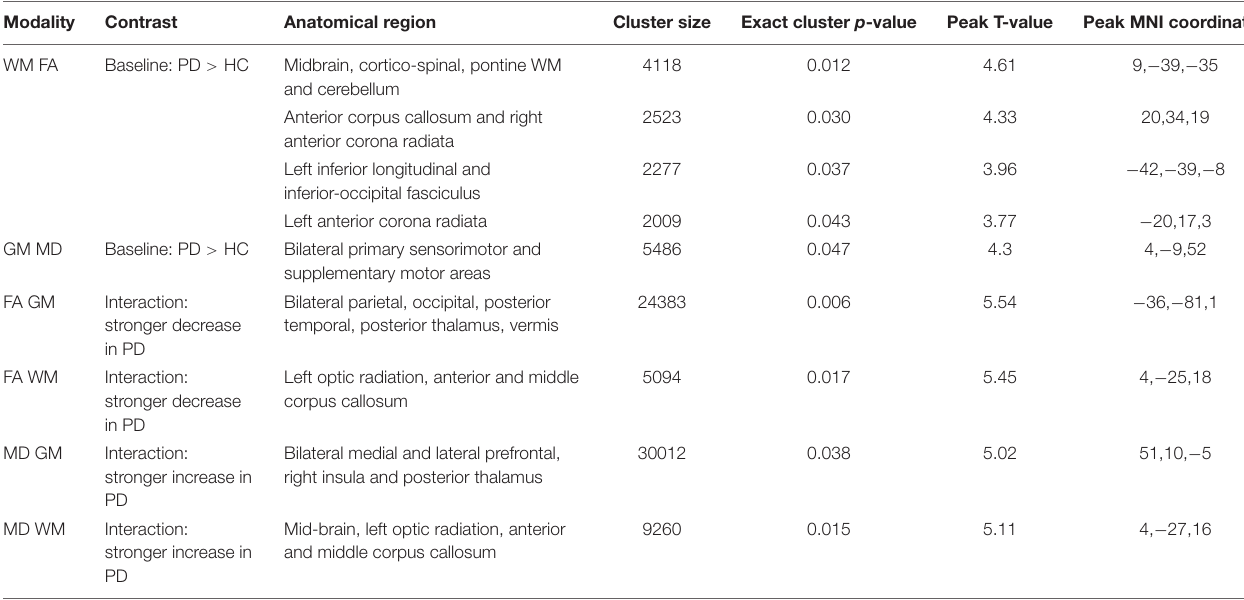
TABLE 2 | Results of voxel-wise analyses of FA and MD